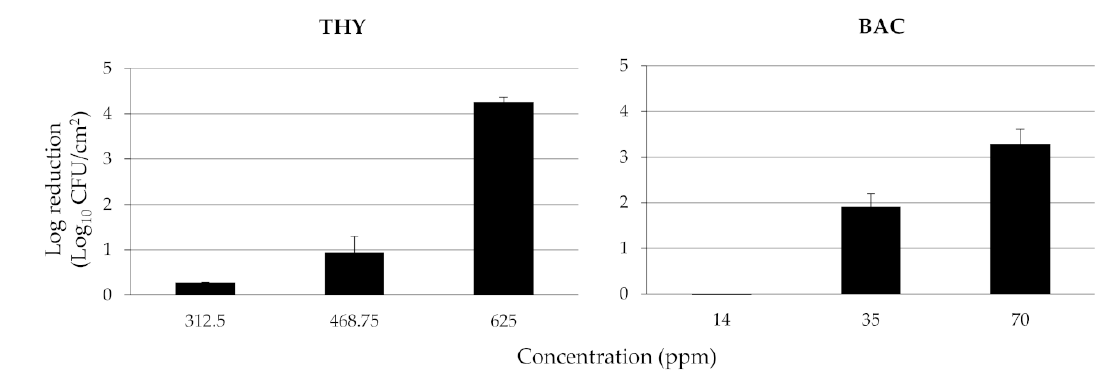
Figure 4. Log reductions of attached/biofilm cells on SS coupons (Log 10 CFU/cm 2 ), of the four-strain L. monocytogenes cocktail, following the 15 min disinfection exposure to either thymol (THY) or benzalkonium chloride (BAC), each applied at three different concentrations (ppm). The bars represent the mean values ± standard deviations ( n = 6).